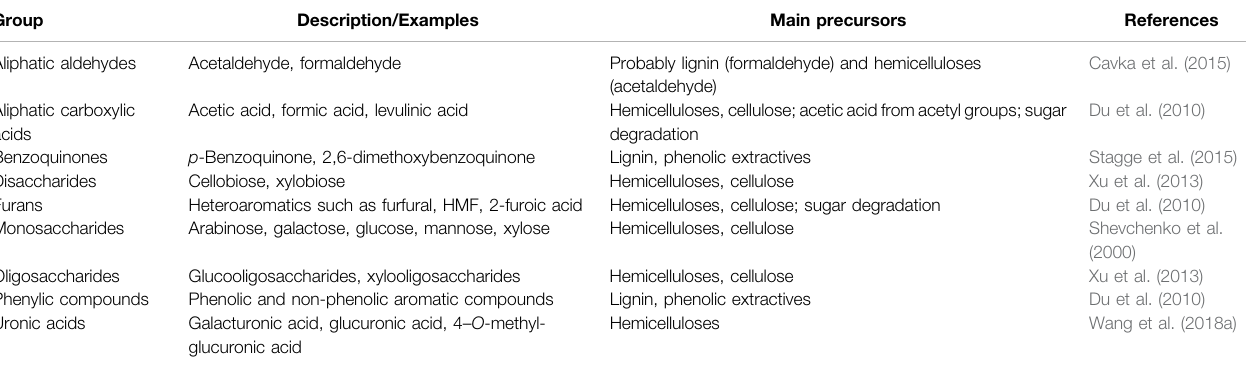
TABLE 4 | Groups of products and by-products solubilized by hydrothermal